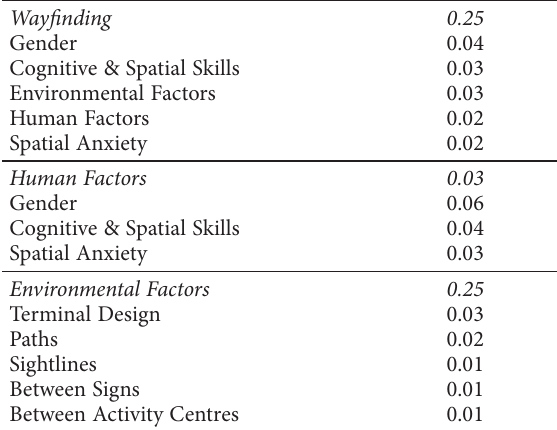
Table 4. Sensitivity analysis for the posterior network of the Wayfinding Bayesian Network (three analyses were performed: one for the output node, Wayfinding, and one each for the internal nodes, Human Factors and Environmental Factors; these nodes of interest were used as the reference point for the other nodes)